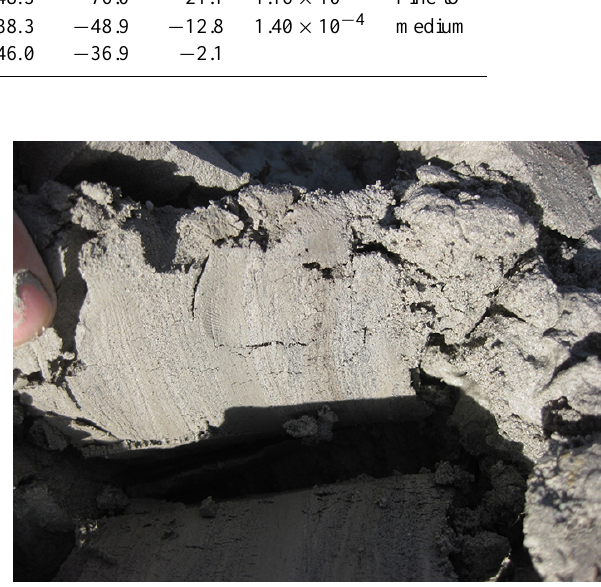
Figure 8. Fine sand sample with thin silty intercalations – test field FS/SU1